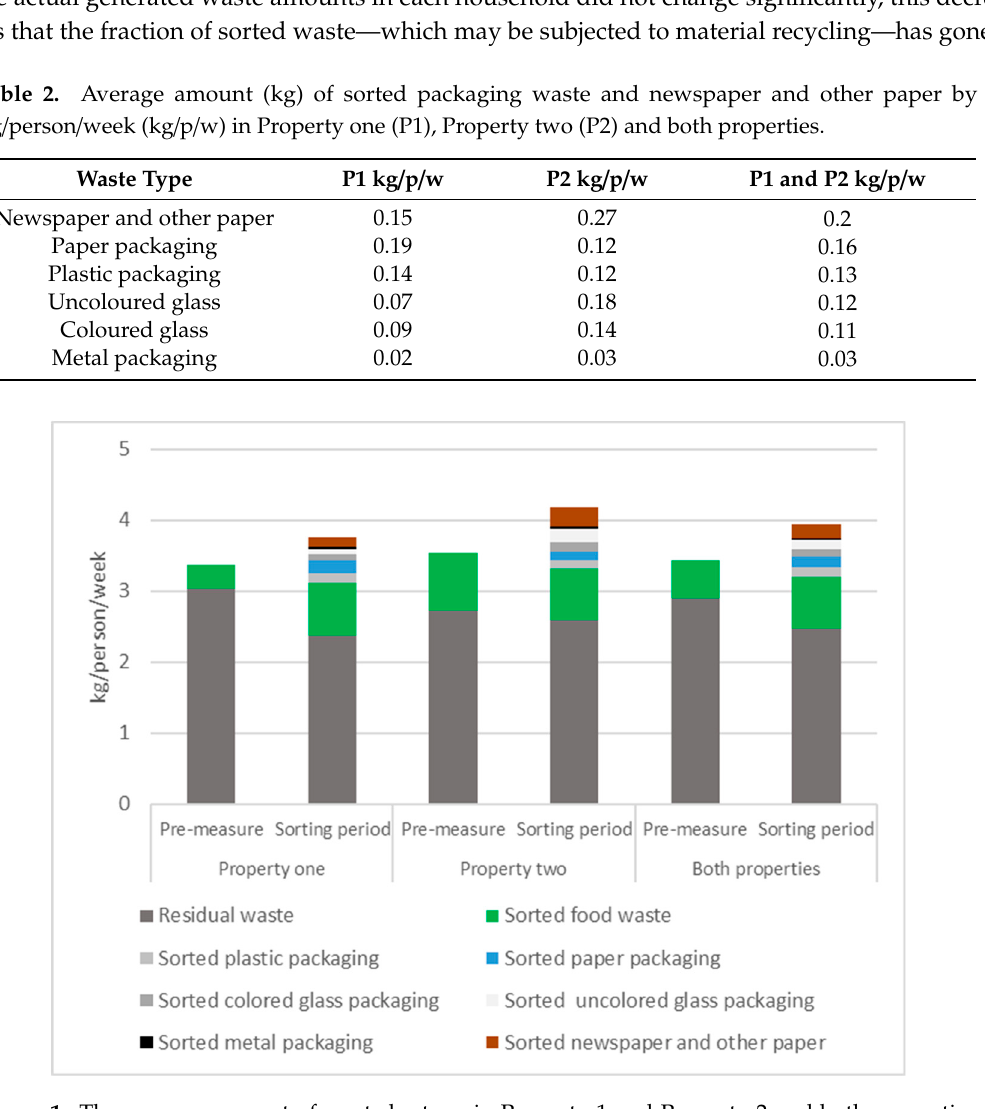
Figure 1. The average amount of waste by type in Property 1 and Property 2 and both properties during pre-measure and sorting period (kg/person/